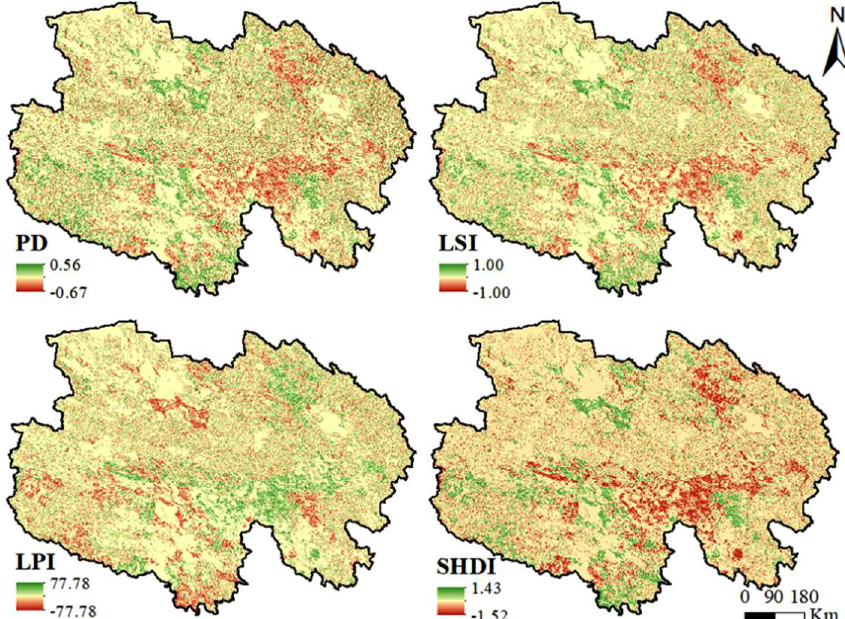
Figure 3. Changes in landscape pattern index values from 1995 to 2020 (made in ArcGIS 10.4.1, https:// www. esri. com/ zh- cn/ arcgis/ produ cts/ arcgis- deskt op/ resou